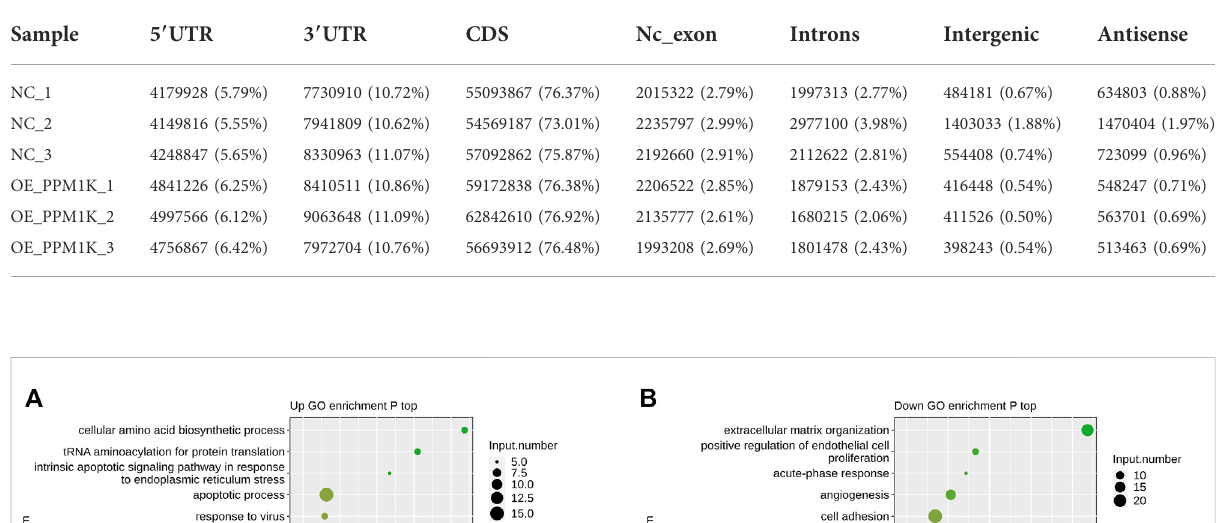
TABLE 3 Reads distribution across reference Genomic Regions.